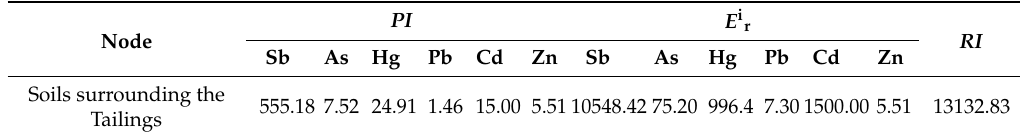
Table 5. Evaluating results by PI , E i r , and RI for the soils surrounding antimony